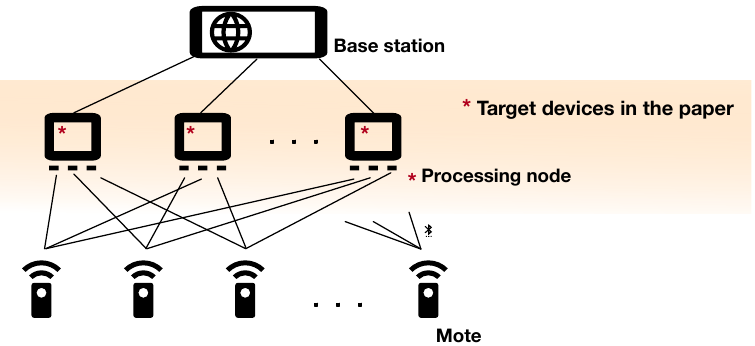
Figure 1. The target vehicular sensor network: the motes collect data and send them to the processing nodes. Each processing node processes the tasks assigned from the motes and sends the result to the base station. It is supposed that both the motes and processing nodes are distributed in different locations on the